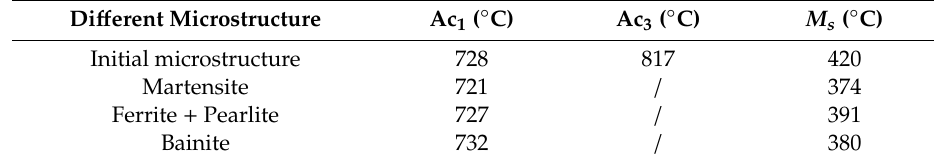
Table 1. The austenite formation temperature (Ac 1 ) for different initial starting microstructures and martensite starting ( M s ) temperature temperature after austenitization or intercritical annealing process.